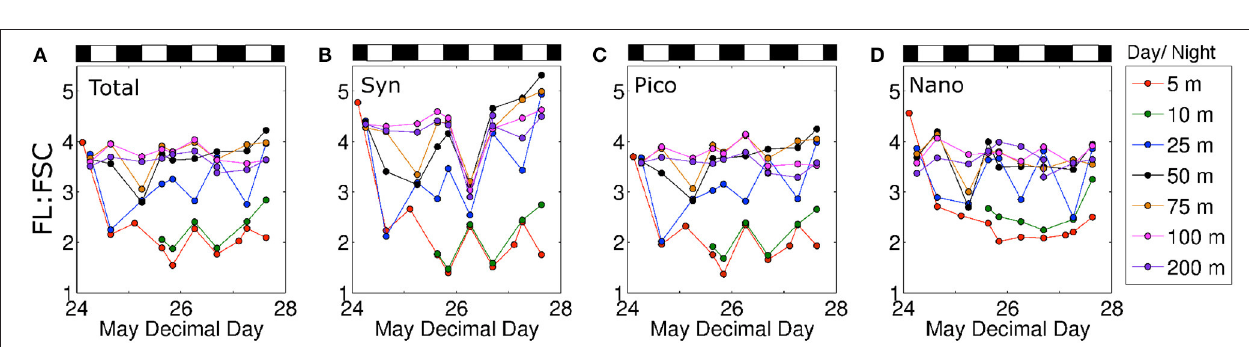
FIGURE 4 | (A) Average daily accumulation rate of total forward scatter (FSC) during station occupation. Bars represent one standard deviation. (B) Accumulation of total community forward scatter, fluorescence, and HPLC Chl a for 5m (solid lines) and forward scatter and fluorescence for 200 m samples (dashed lines). Values are normalized to first samples collected within hours of arriving on station. (C) Total community FSC at 5 m normalized to first sample collected (same data as in B but on log scale).